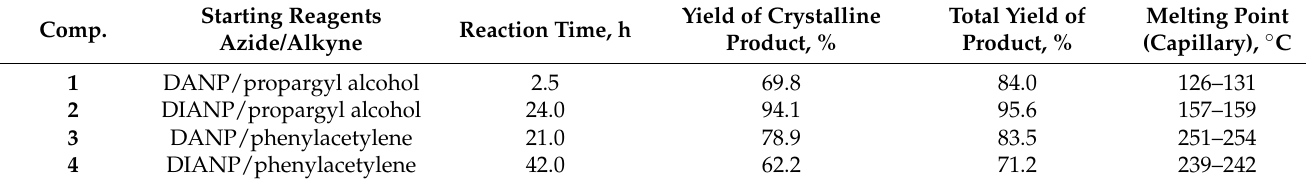
Table 6. Cyclization results of DANP and DIANP with propargyl alcohol and phenylacetylene.